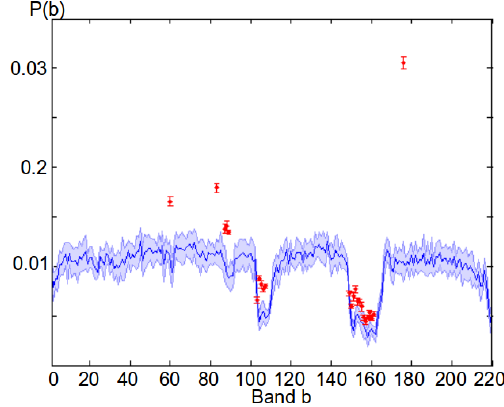
Figure 9: Usage frequency of all (blue) and selected (red) spectral